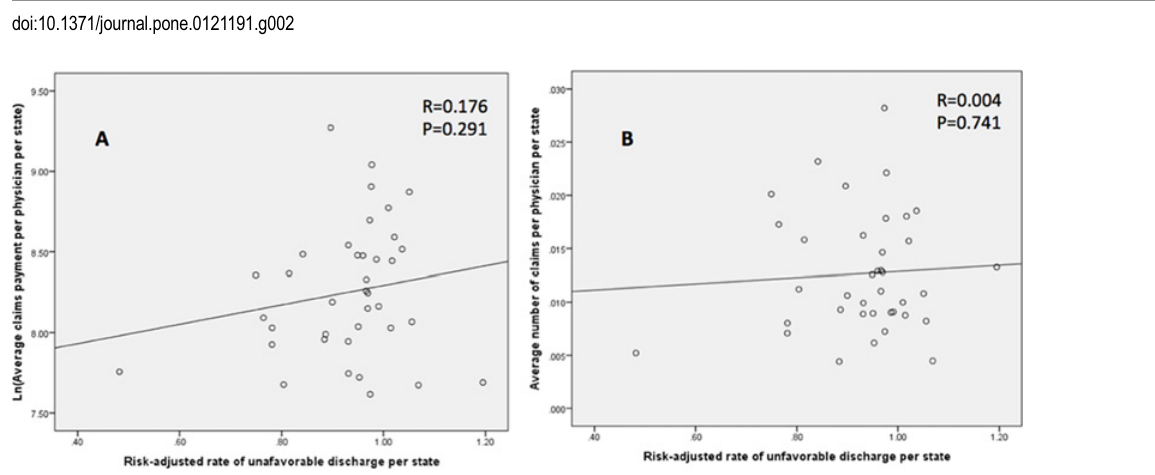
Fig 3. Scatter plot demonstrating the correlation of average state-level length of stay for cranial neurosurgical procedures and average size (ln- transformed) (A) and number (B) of paid claims per physician per state.